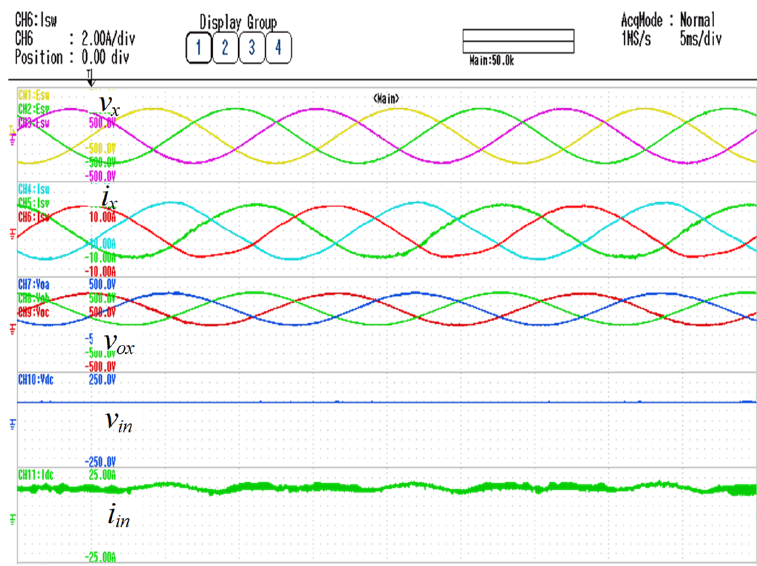
Figure 8. Experimental results of the proposed IFBI with SOHC at 1.6 kW.